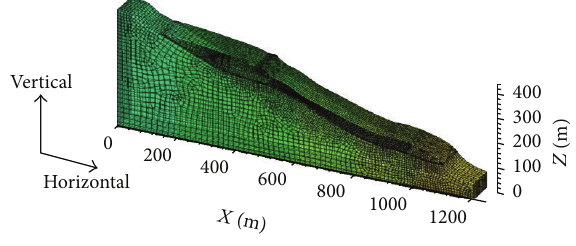
Figure 6: Finite element model.